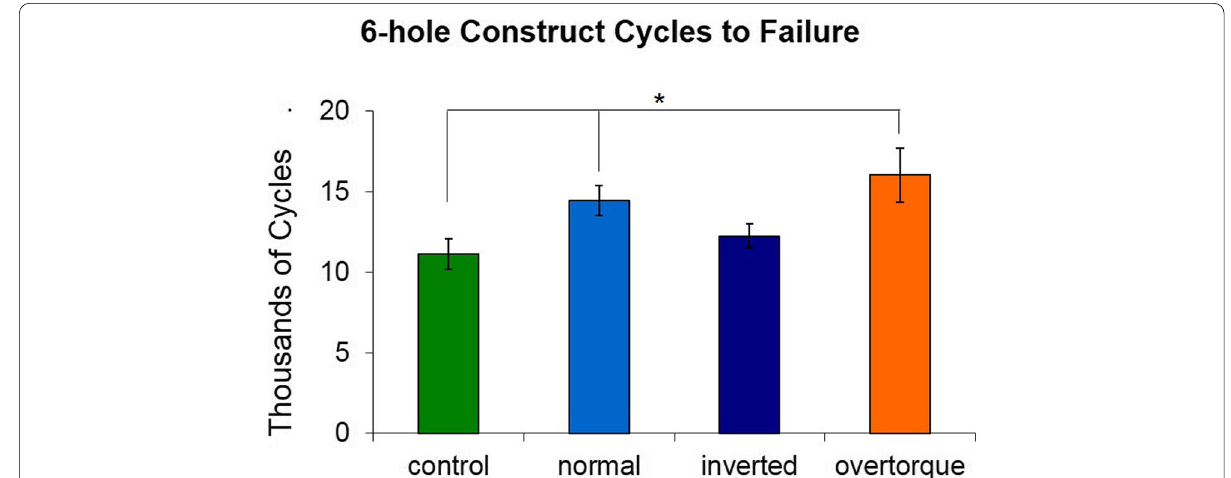
Fig. 6 Average cycles to failure for six-hole constructs (mean standard deviation). The overtorque group had significantly more cycles to failure ± than control, normal, and inverted group. The control group also had significantly fewer cycles to failure that the normal torque group. The inverted group did not differ from the normal